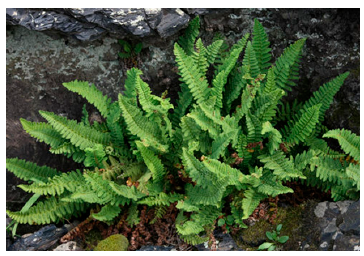
Figure 1. D. fragrans plant.